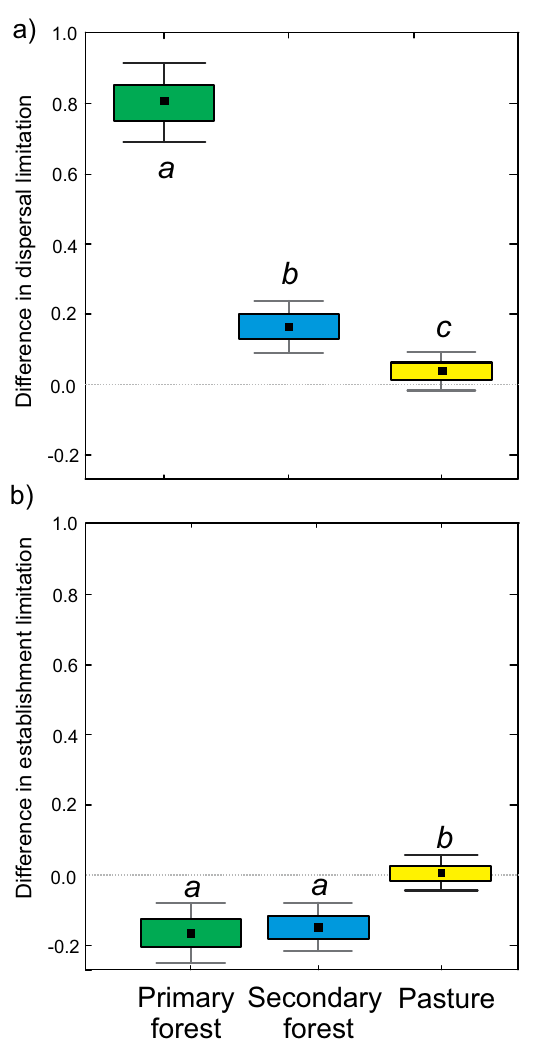
Figure 3. Differences between the presence and the density-weighted index in estimating dispersal ( a ) (H (2,40) = 30.9, p ˂ 0.001), and establishment limitation ( b ) (H (2,40) = 13.6, p ˂ 0.001) by habitat. Squares are means, boxes are standard deviations and lines indicate 95% confidence intervals. Green boxes show the primary forest, blue boxes, the secondary forest and yellow boxes, the pasture. Different letters indicate significance based on Kruskal-Wallis tests within each frame. See text for relevant comparisons between frames.